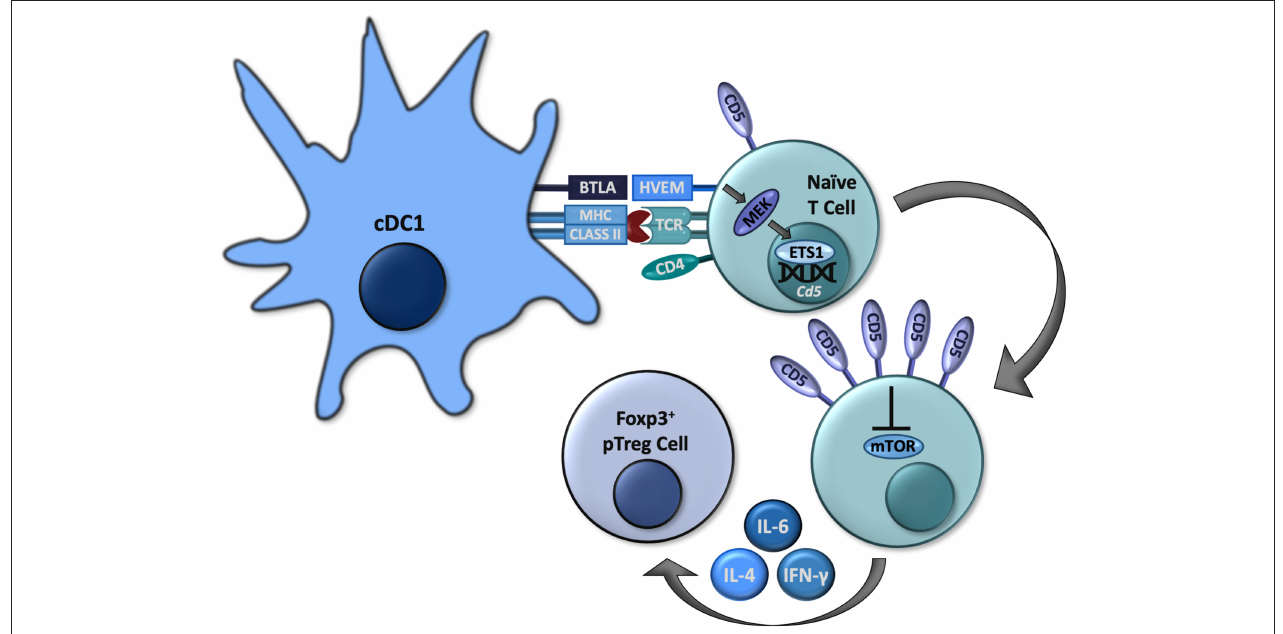
FIGURE 1 | Some cDC1s express BTLA, which can signal through HVEM in naïve CD4 + T cells to activate MEK and subsequently ETS1 to increase expression of Cd5 . High CD5 expression allows these to cells to convert to Foxp3 + pTreg cells by interfering with mTOR activation, even in the presence of effector-differentiating cytokines such as IL-4, IL-6, and IFN- γ